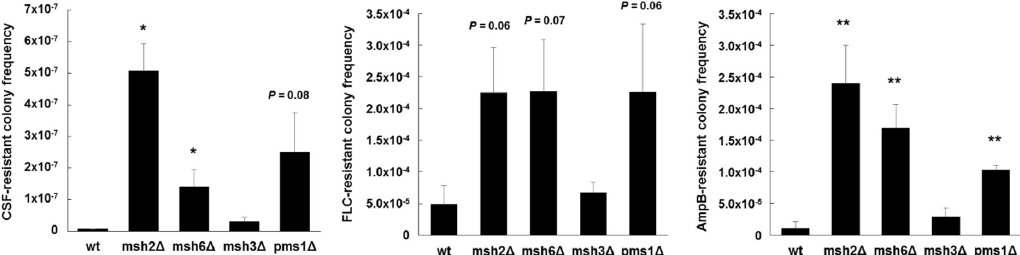
Figure 3. Echinocandin, azole, and polyene resistant colony frequencies of C. glabrata mismatch repair deletion strains. Strains were selected agar plates containing 1 µ g/mL of caspofungin (CSF), 256 µ g/mL of fluconazole (FLC), or 2 µ g/mL of amphotericin B (AmpB) (panels left to right) (all concentrations 8-16x the corresponding MIC). Dilutions were plated onto drug-free media to determine exact CFU counts. Frequencies were calculated as the number of colonies on the drug plate divided by the total CFU plated. Frequency averages were calculated from at least three independent selections. * p < 0.05 and ** p < 0.01 (student’s t -test; two-tailed).